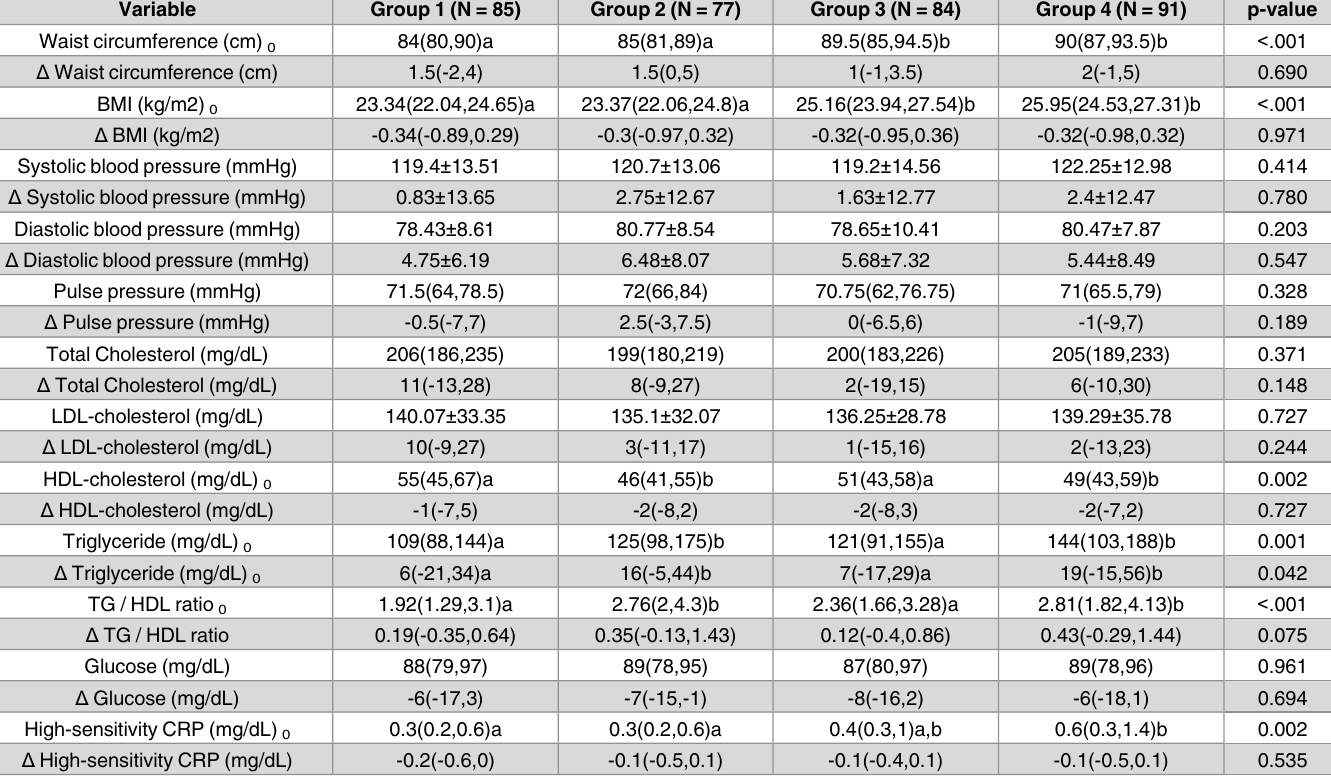
Table 2. Follow-up characteristics and their respective variations from the